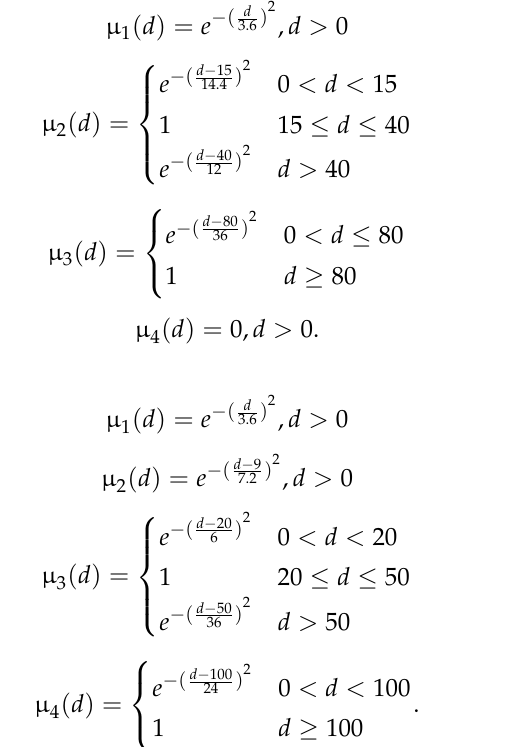
Figure 2. Membership function of mean shear wave velocity.